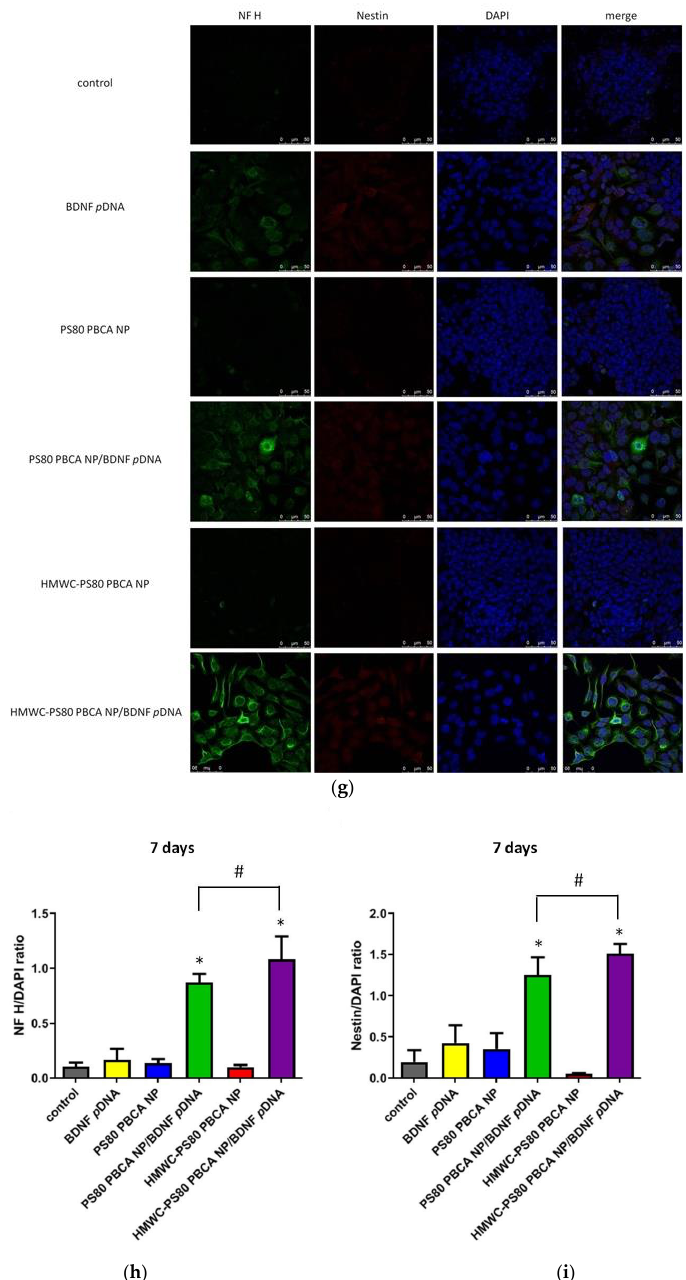
Figure 10. ( a ) Immunofluorescence staining of mouse iPSCs expressing BDNF and Tropomyosin-related kinase B (TrkB) at day-2 of transfection with prior exposure to hypoxia. Transfection was performed with BDNF p DNA (2 µ g/mL), PS80 PBCA NP (30 µ g/mL), PS80 PBCA NP/BDNF p DNA polyplex (30 µ g/mL:2 µ g/mL), HMWC-PS80 PBCA NP (30 µ g/mL) or HMWC-PS80 PBCA NP/BDNF p DNA polyplex (30 µ g/mL:2 µ g/mL). ( b ) BDNF and ( c ) TrkB fluorescence intensities